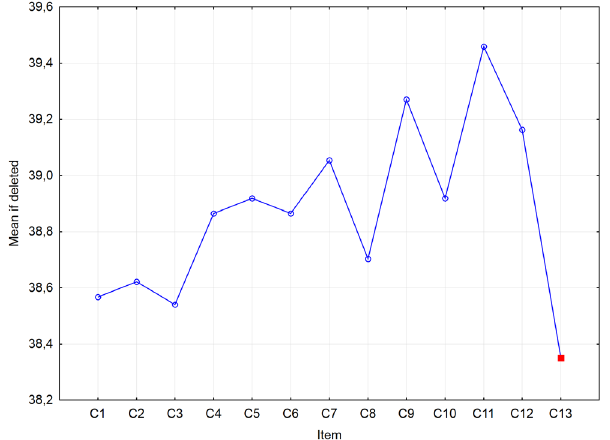
Fig. 5. Average values of the questionnaire total score after the relevant item elimination